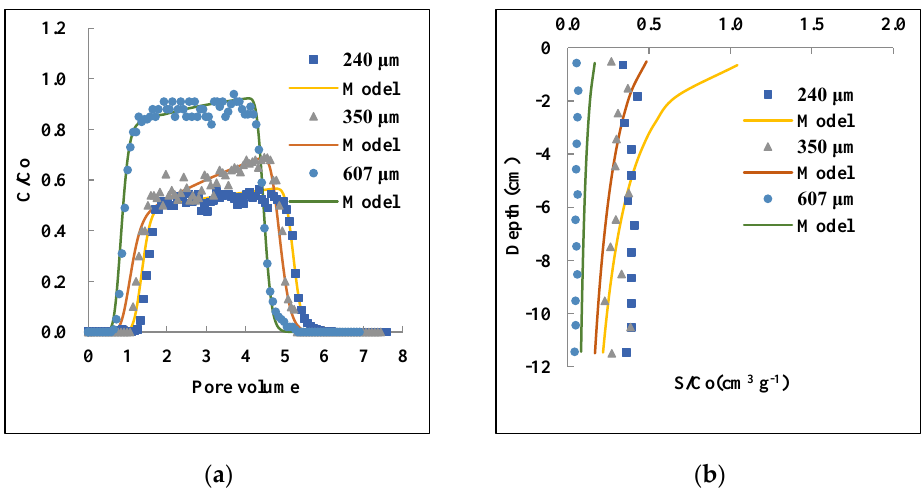
Figure 4. Effect of grain size 607, 350, and 240 µm on the transport and retention of PAM@MNP in saturated QS: Observed and modeled BTCs ( a ) and RPs ( b ). Initial concentration: 10 mg L −1 , IS: 1 mM, Darcy velocity: 0.29 – 3.0 cm min −1 .